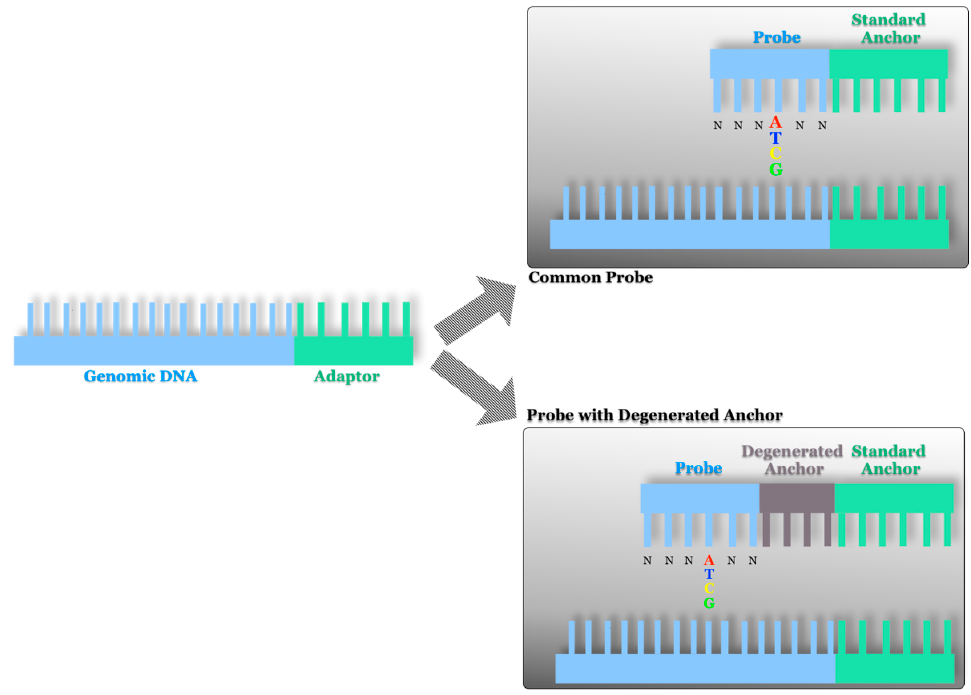
Figure 8. Combinatorial probe anchor ligation in the CG platform. The probes contain degenerate and fluorophore-tagged DNA fragments attached to the standard anchor sites.